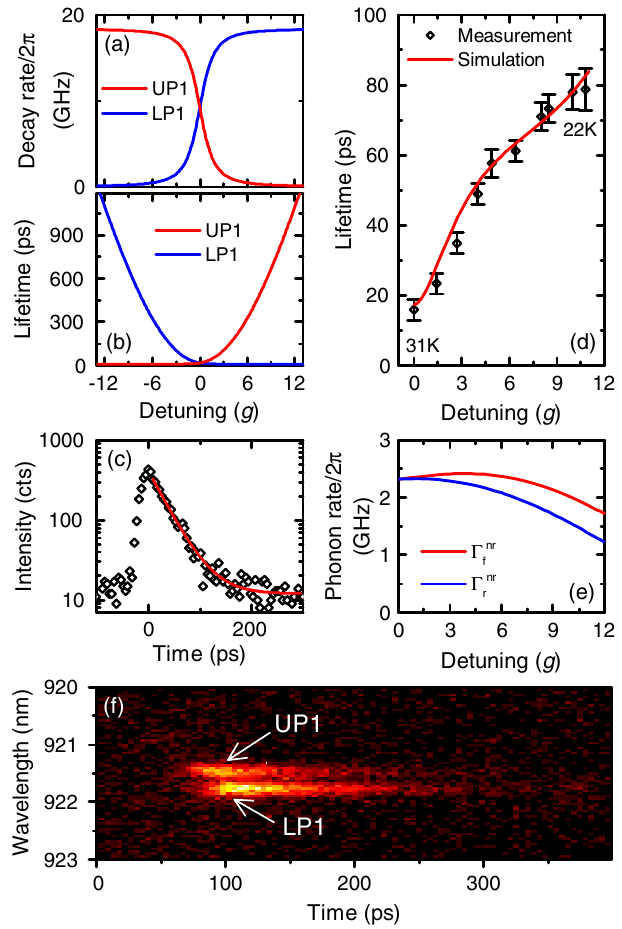
FIG. 2. (a) Decay rates and (b) resulting lifetimes of the polariton branches as functions of the QD-cavity detuning, obtained from Eq. (2). (c) Time-resolved spectrally integrated luminescence intensity at a detuning of Δ ¼ 2 . 8 g for excitation of UP1. The lifetime is extracted from a mono-exponential fit (shown in red). (d) Measured and simulated lifetime of UP1 as a function of the detuning. (e) Phonon-assisted state transfer rates extracted from the lifetime at each detuning. (f) Spectrally and temporally resolved luminescence at a QD-cavity detuning of Δ ¼ 7 g . The delayed onset of emission from LP1 for resonant excitation of UP1 is consistent with phonon-assisted population